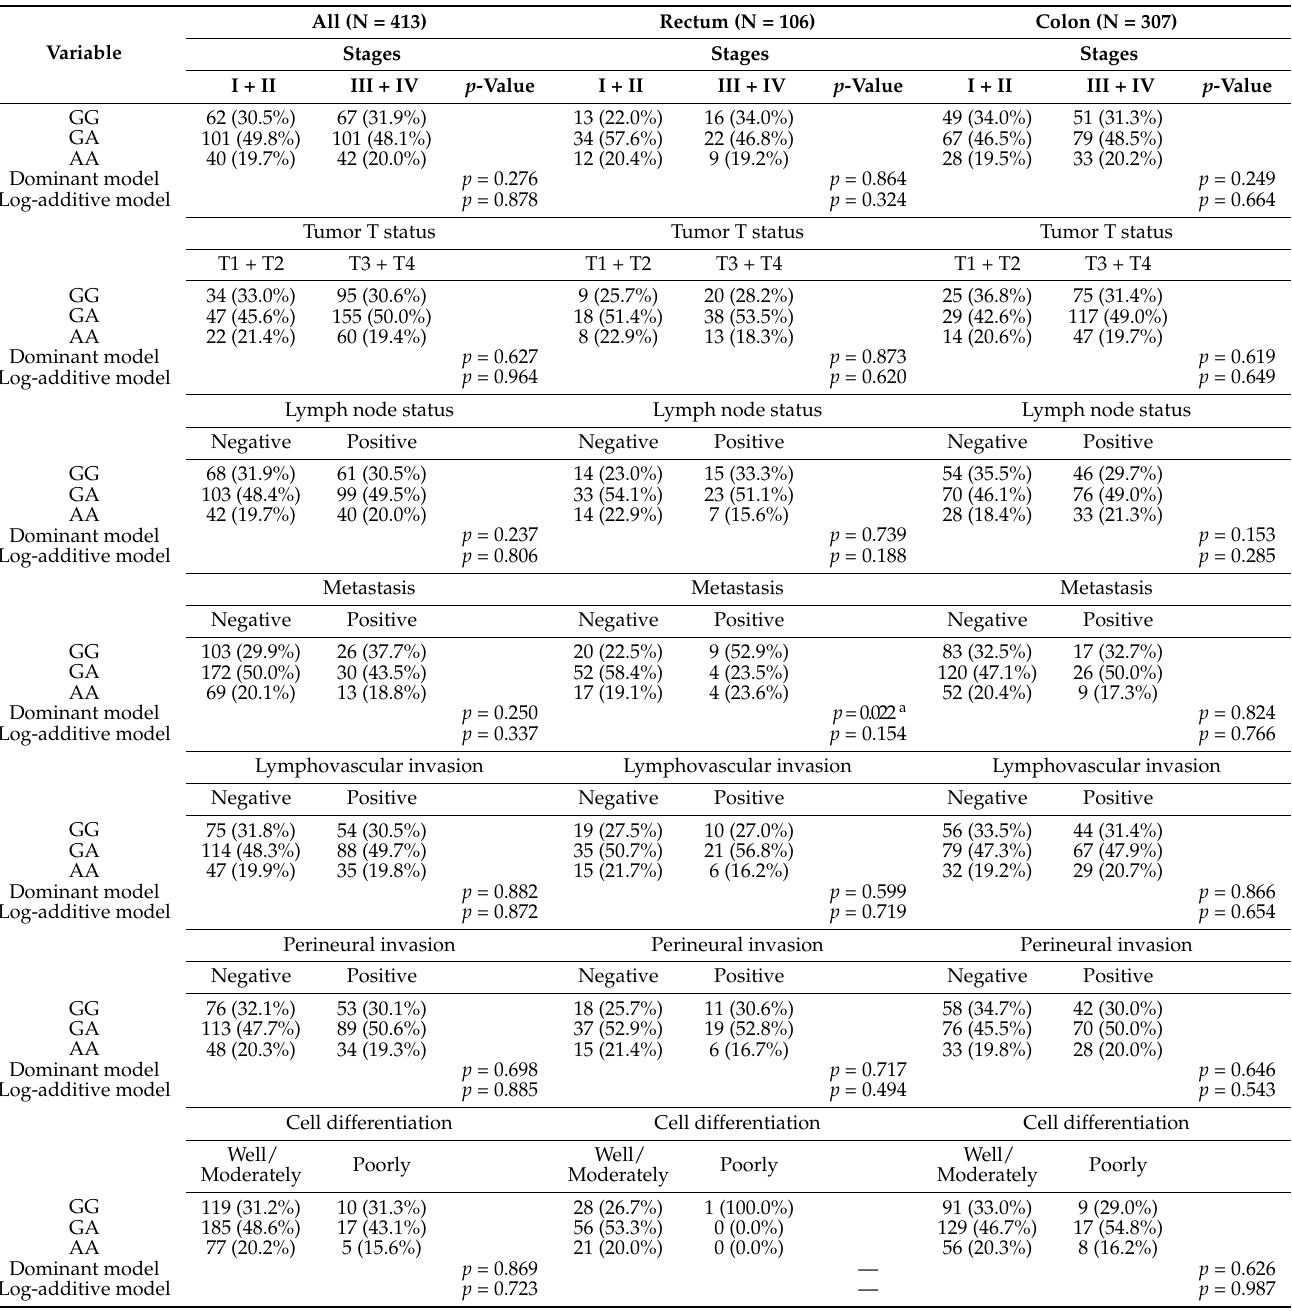
Table 4. Distribution frequency of the clinical status and FGFR4 rs1966265 genotype frequencies in 413 CRC